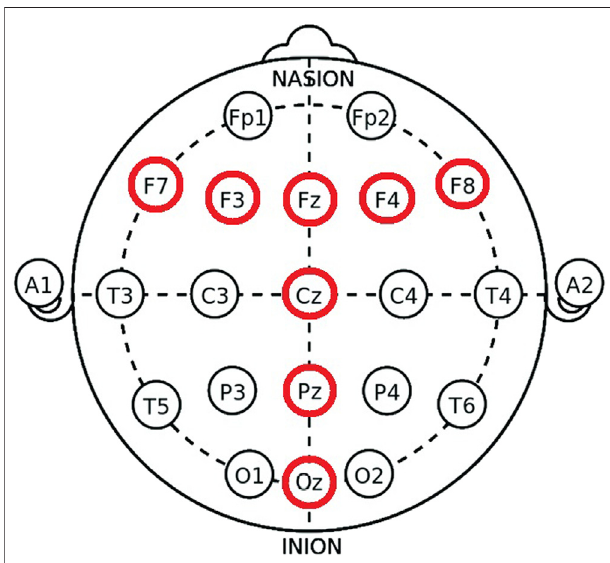
FIGURE3 | 10 – 20Diagram with red circles indicatingthe F7, F3, Fz,F4, F8, Cz, Pz and Oz sites recorded during the study.